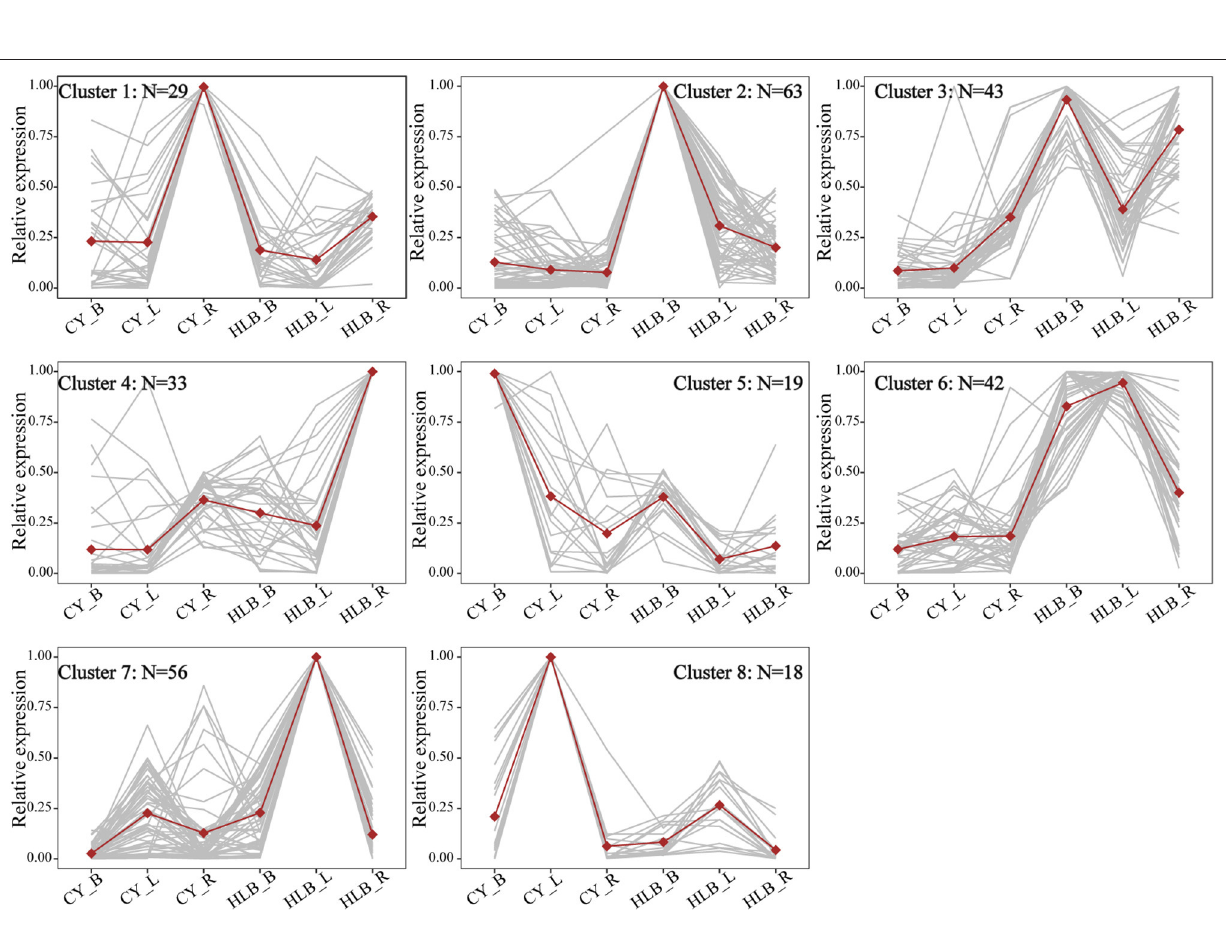
Frontiers in Plant Science |